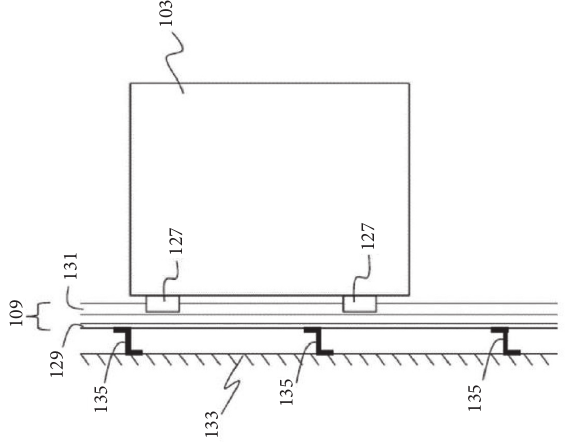
Figure 4: Settlement curves of each calculated